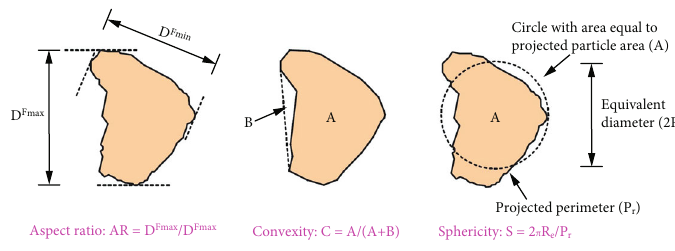
Figure 3: De fi nition of shape and size indices [29]. Table 2: The shape data of the eight materials for the minimum Feret ( D F min )